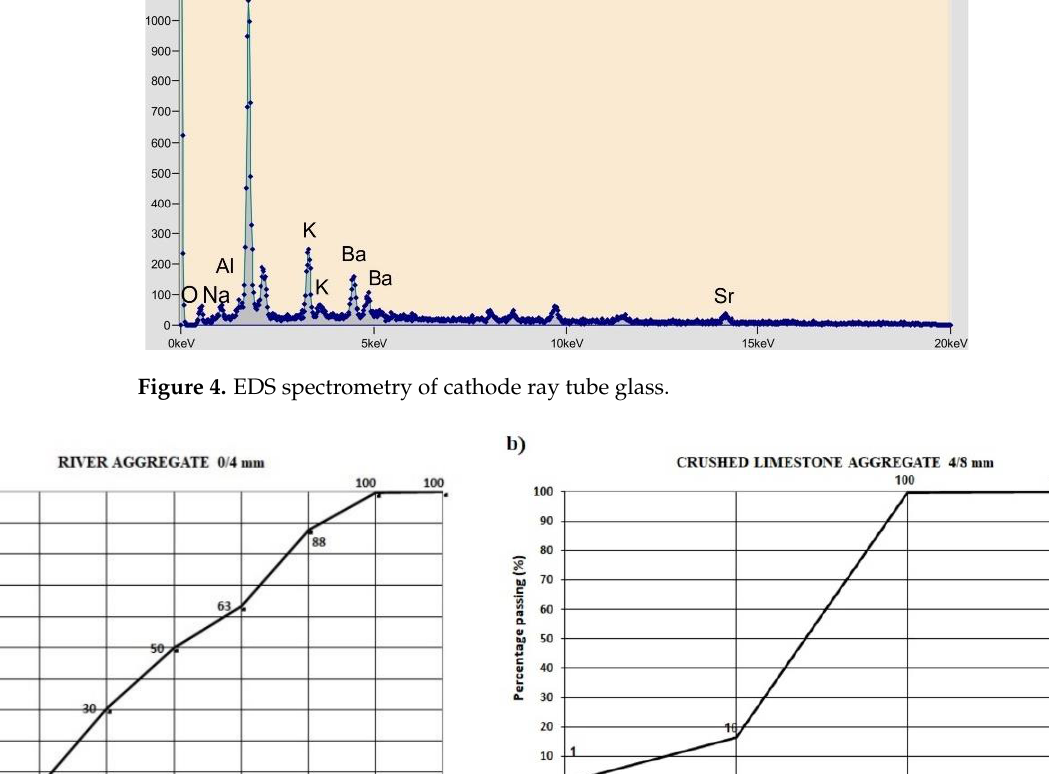
Table 3. Physical properties of fine aggregates and coarse aggregates.